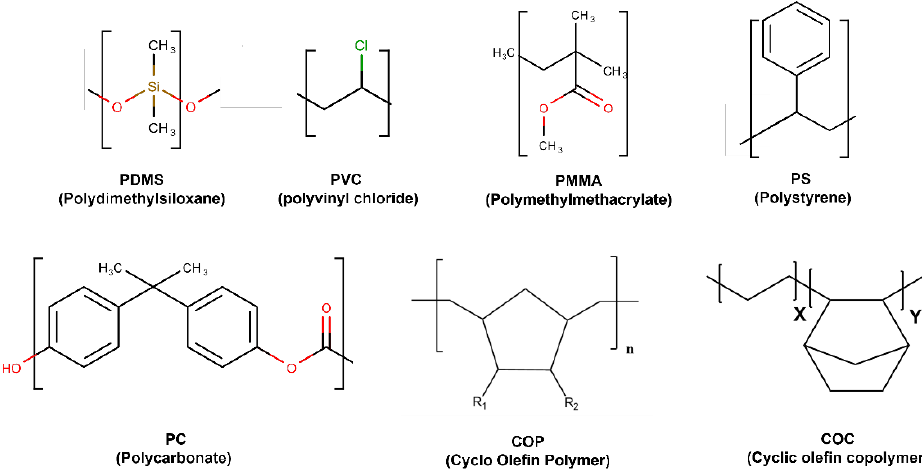
Figure 4. Most used thermostable polymers structures for microfluidic chips.